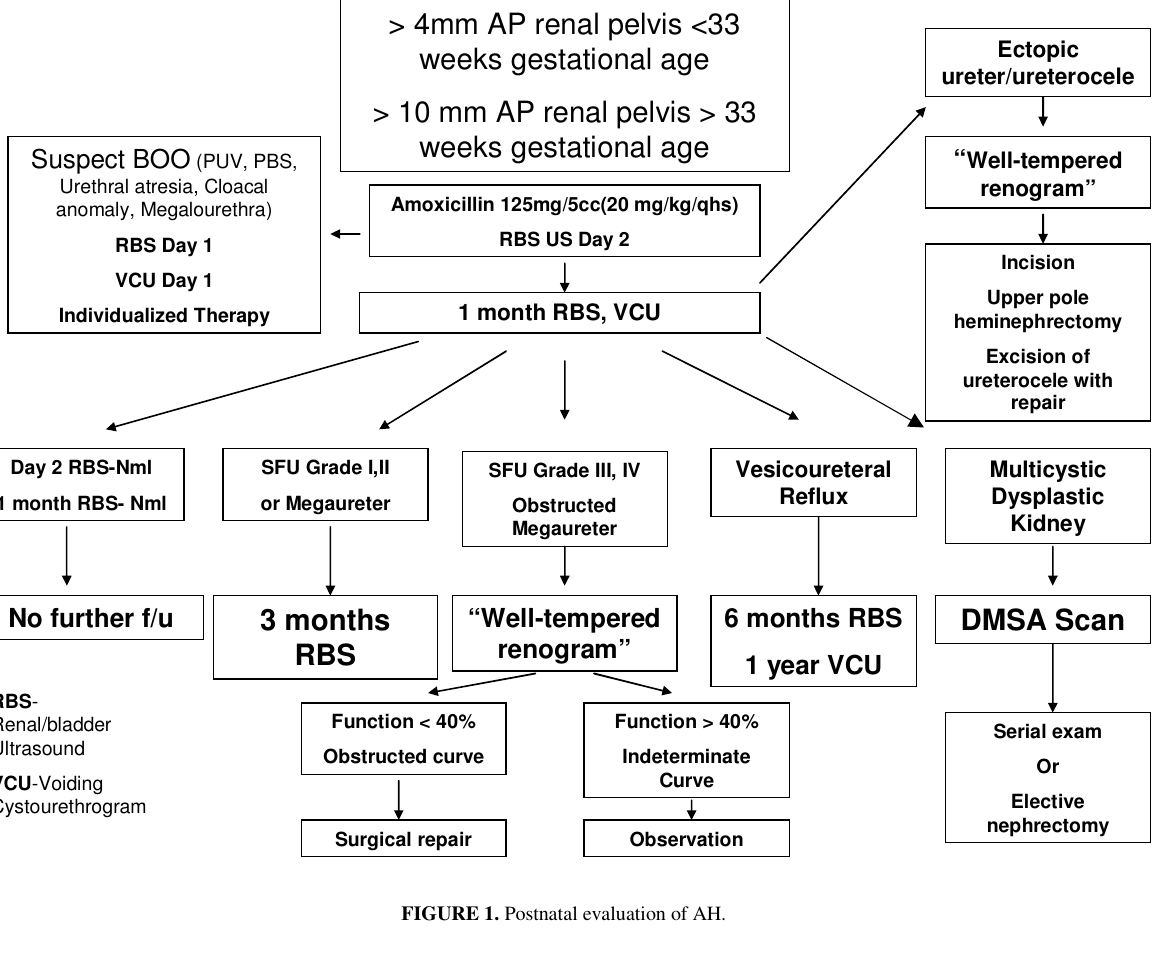
FIGURE 1. Postnatal evaluation of AH.